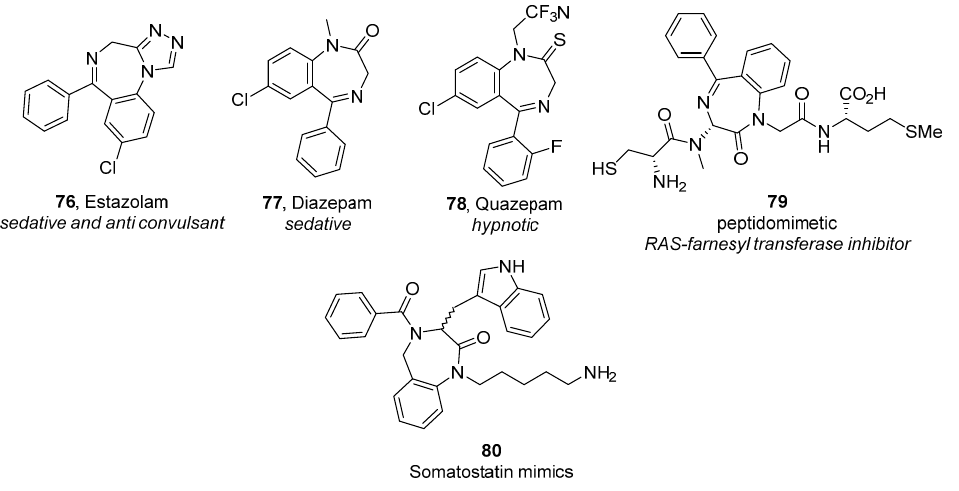
Figure 7. Relevant examples of bioactive benzodiazepines.